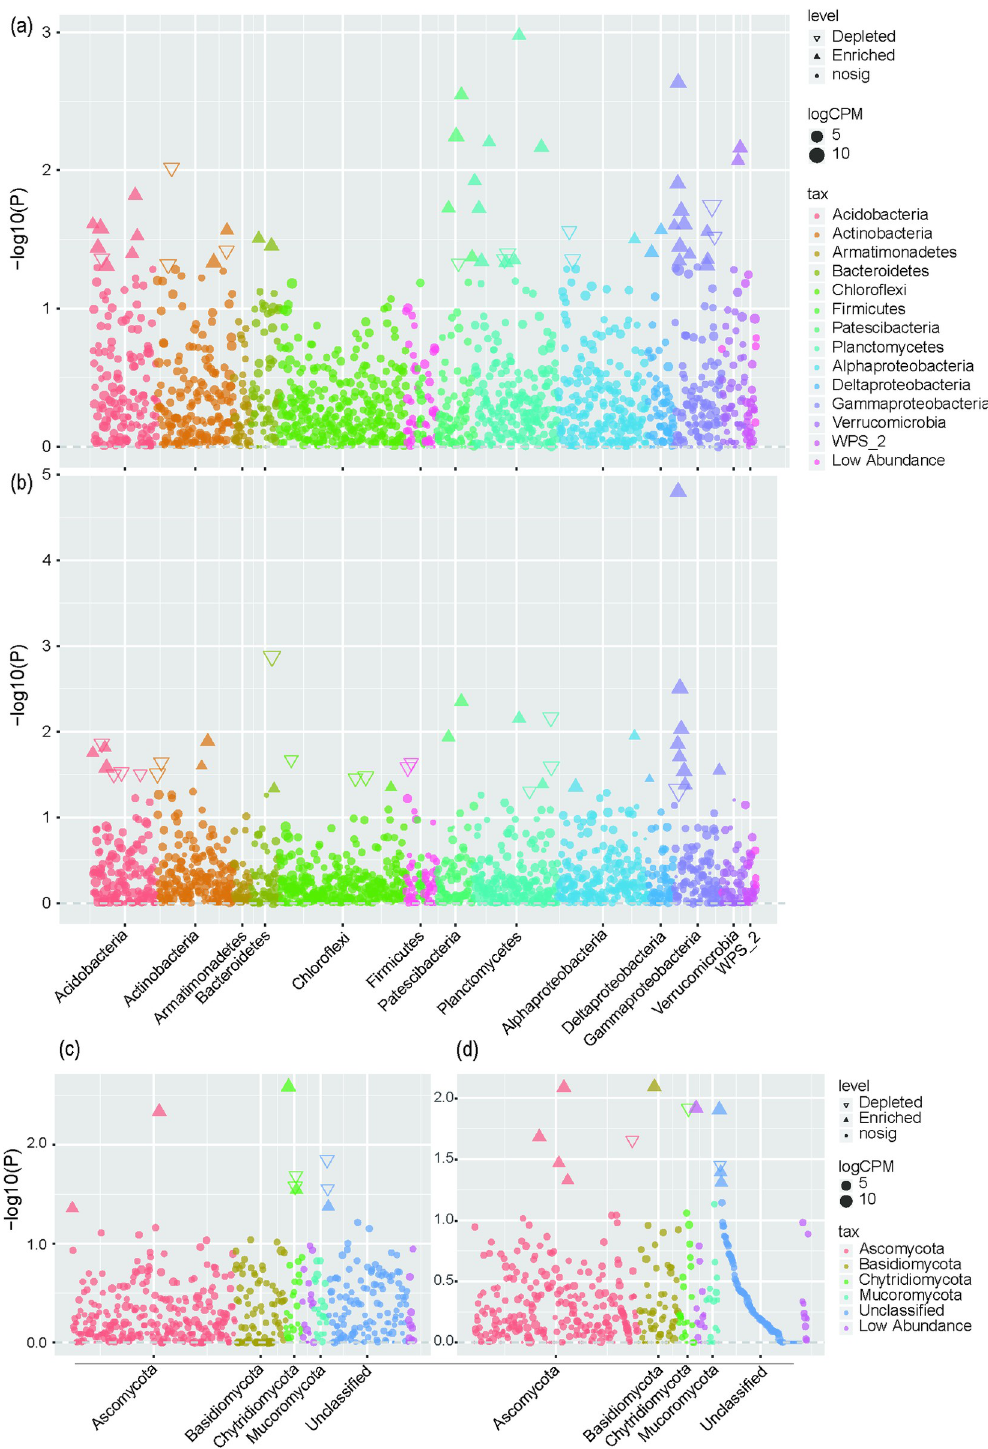
Fig 3. Taxonomic diagram of different bacterial and fungal between the WS1 and WS2 soil microbiota. Manhattan plot showing OTUs enriched in soil in WS1 (a, c) and WS2 (b, d). CK: N, P, and K fertilizer; WS1: water soluble fertilizer 1,050 kg/hm 2 ; WS2: water soluble fertilizer 1,650 kg/hm 2 .